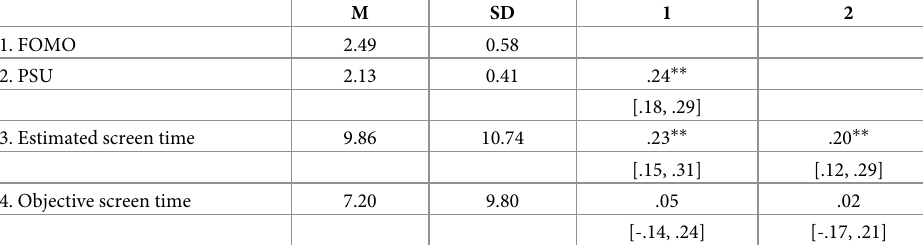
Table 3. Pearson correlations between fear of missing out (FOMO), problematic smartphone use (PSU), and esti- mated/objective screen time. M SD 1